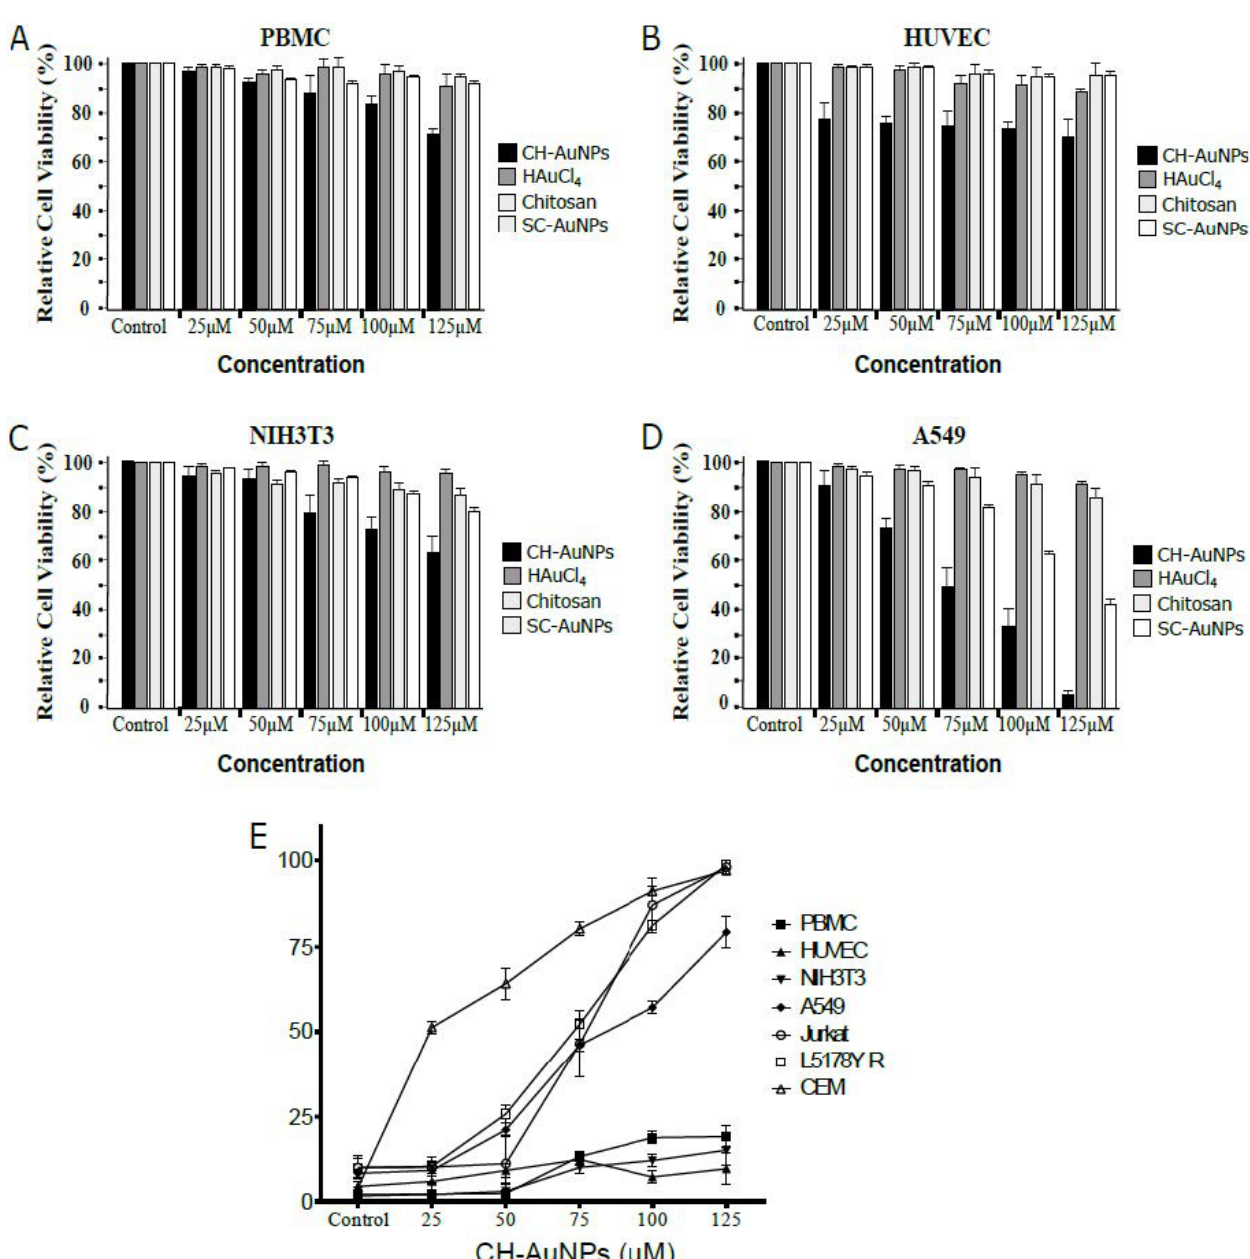
Figure 2. Cytotoxic effect of CH-AuNPs, HAuCl 4 , chitosan, and SC-AuNPs in non-cancer and cancer cells. ( A ) PBMCs were treated with different concentrations of CH-AuNPs, HAuCl 4 , chitosan, and SC-AuNPs (25, 50, 75, 100, and 125 μM) for 24 h. ( B ) HUVEC, ( C ) NIH3T3, and ( D ) A549 cells were treated as in ( A ). Cell viability was measured by MTT assay. The percentages refer to relative cell viability represented as percentage of control (non-treated cell viability = 100%). ( E ) Quantification of cell death by flow cytometry using annexin V (phosphatidylserine exposure analysis) and propidium iodide (membrane-permeability analysis) staining in PBMC, HUVEC, NIH3T3, A549, Jurkat, L5178Y-R, and CEM cells treated with different concentrations (25, 50, 75, 100, and 125 μM) of CH-AuNPs for 24 h. The results are presented as mean ± standard deviation of three different experiments.